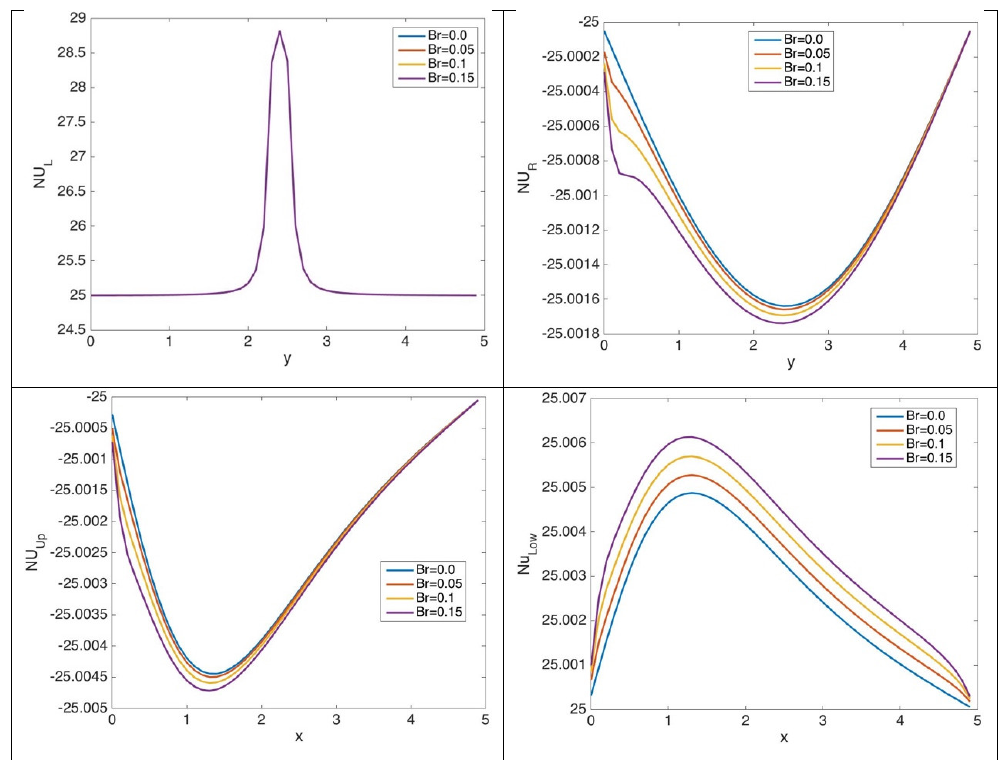
Figure 8. Local Nusselt number distributions along the left wall, right wall, upper wall, and lower wall for various values of the parameter Br of Case 1.